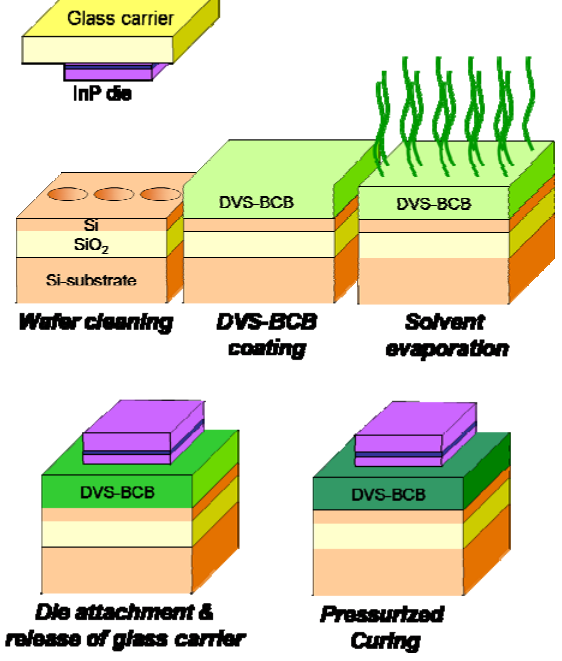
Figure 6. Overview of the DVS-BCB die-to-wafer bonding